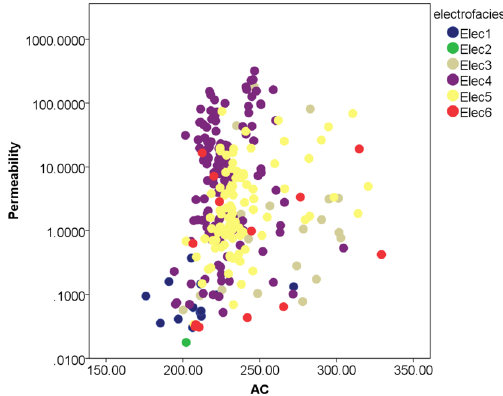
Fig. 16 LLS–K crossplot in electrofacies